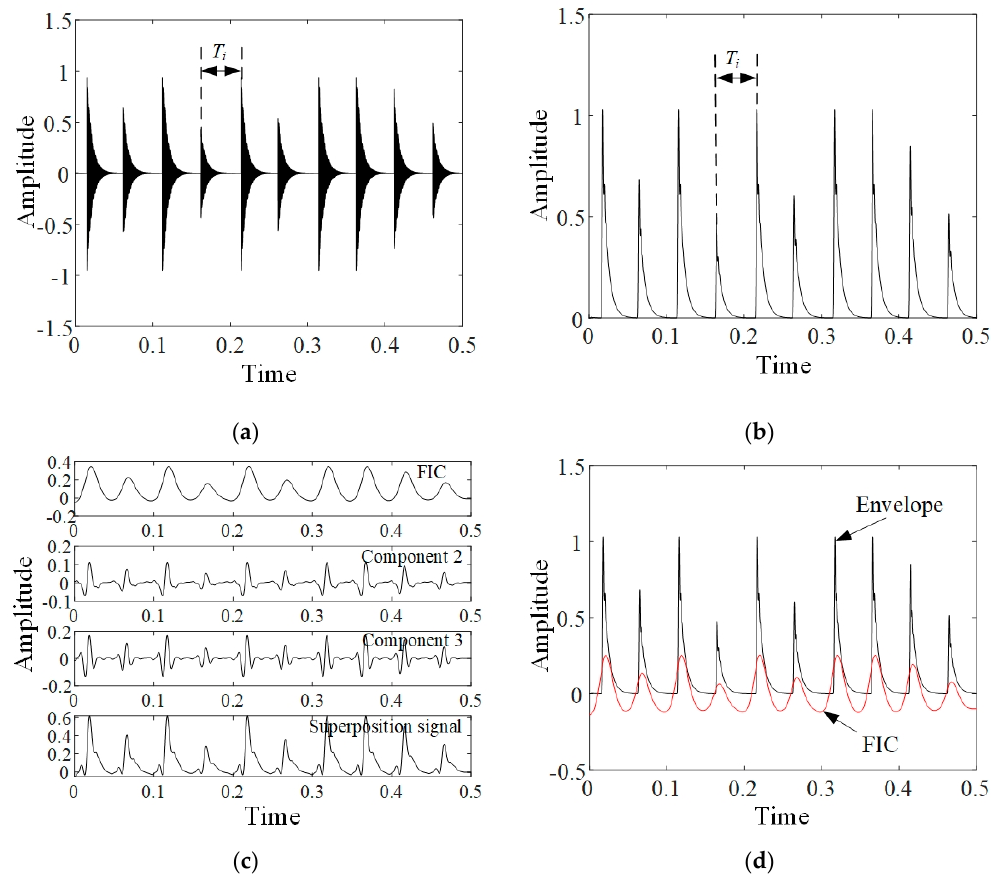
Figure 1. Simulation for pre-processing operations: ( a ) simulated signal; ( b ) envelope of simulated signal; ( c ) signal components decomposed by variational mode decomposition (VMD) and their superposition; ( d ) envelop and failure-induced component (FIC).